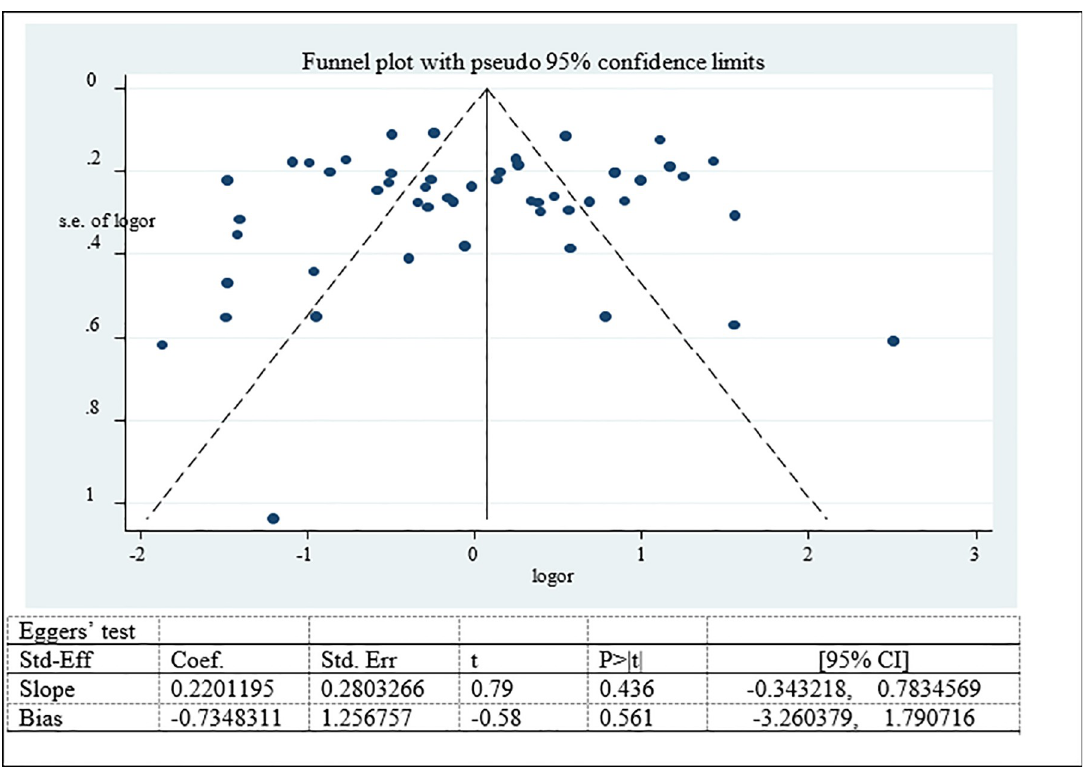
Fig 21. Funnel plot and Eggers’ test to assess publication bias for factor associated with adolescent thinness in Ethiopia.